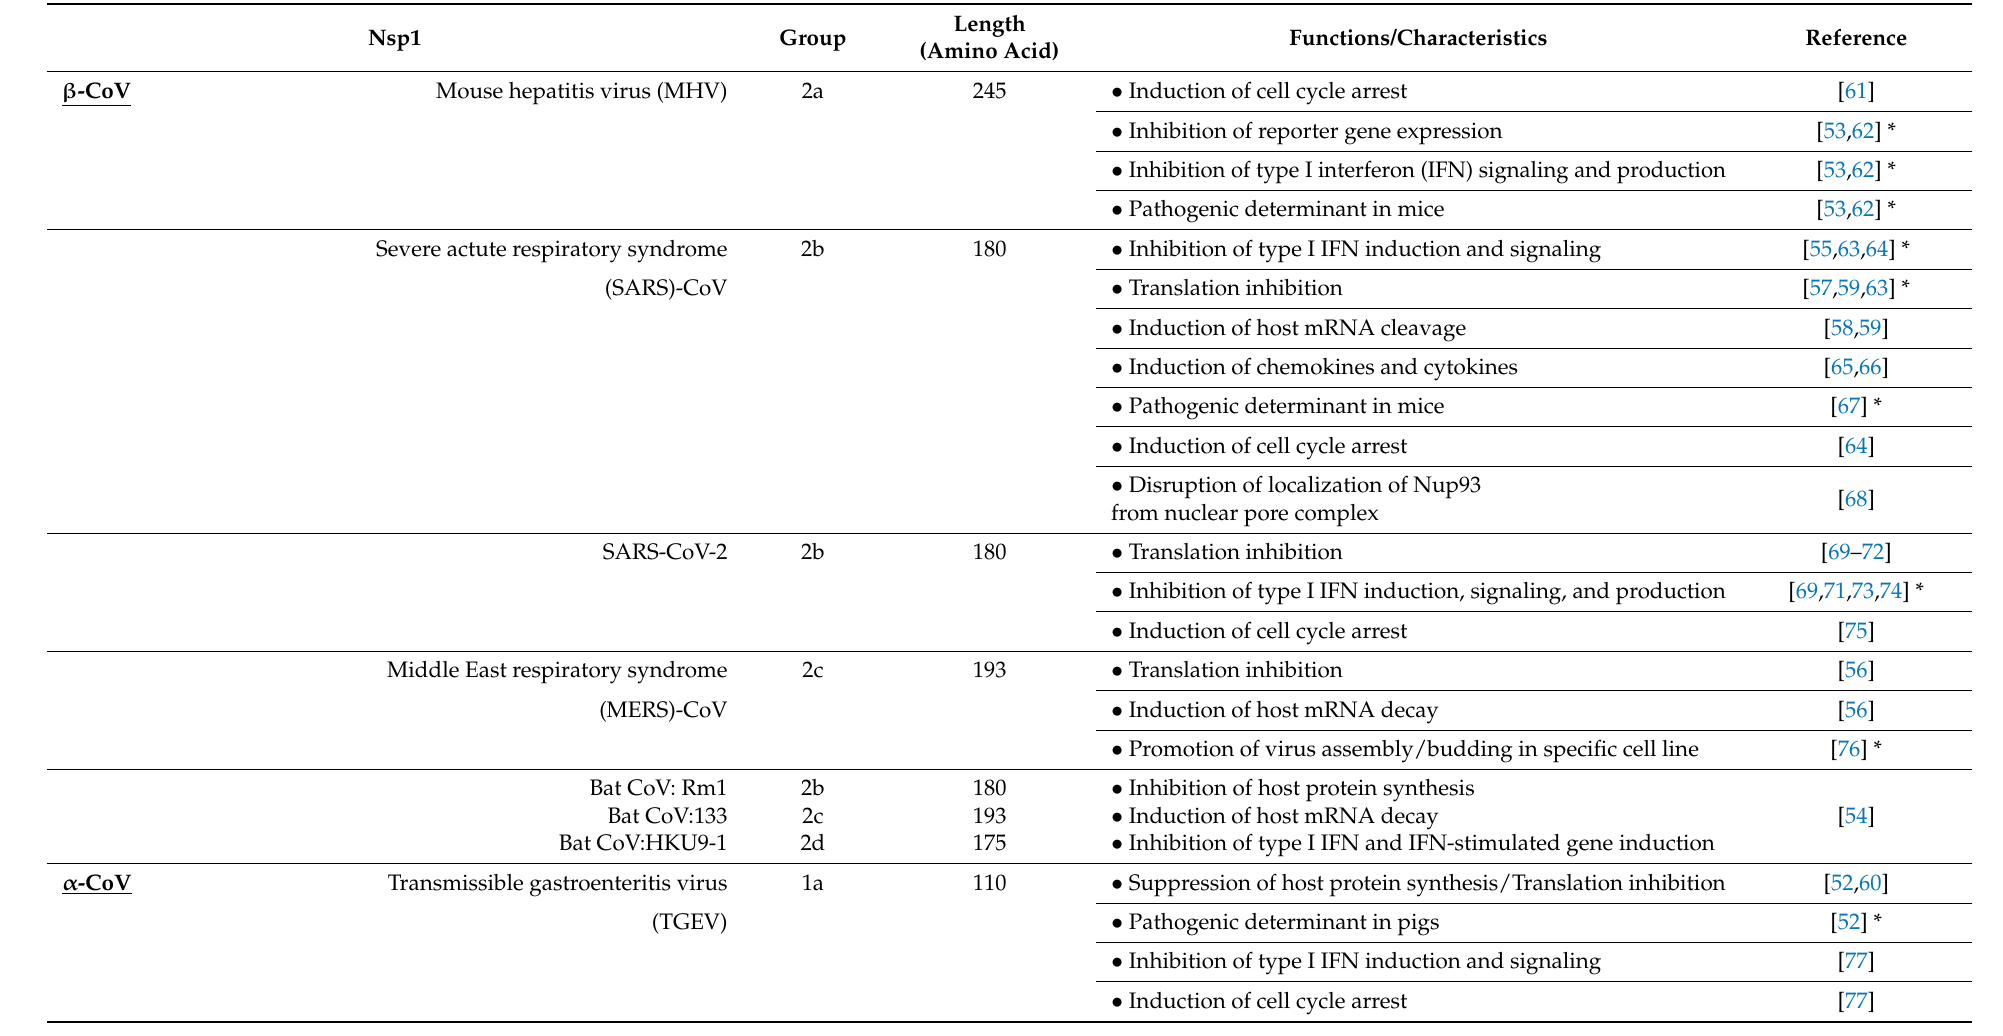
Table 1. Summary of the functions of coronavirus (CoV) nonstructural protein 1